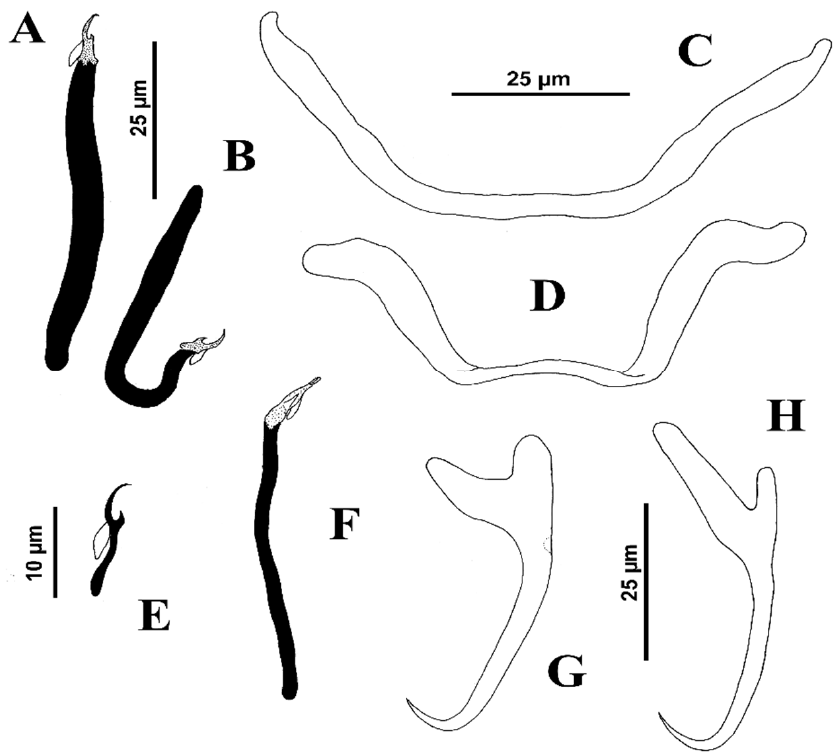
Figure 8. Haptoral structures of Neohaliotrema bychowskii Zhukov, 1976 from Sergeant-major Ab- udefduf saxatilis ( A ) Hook pair 1 ( B ) Hook pair 2 ( C ) Ventral bar ( D ) Dorsal bar ( E ) Hook pair 4 ( F ) Hook pair 3 ( G ) Ventral anchor ( H ) Dorsal